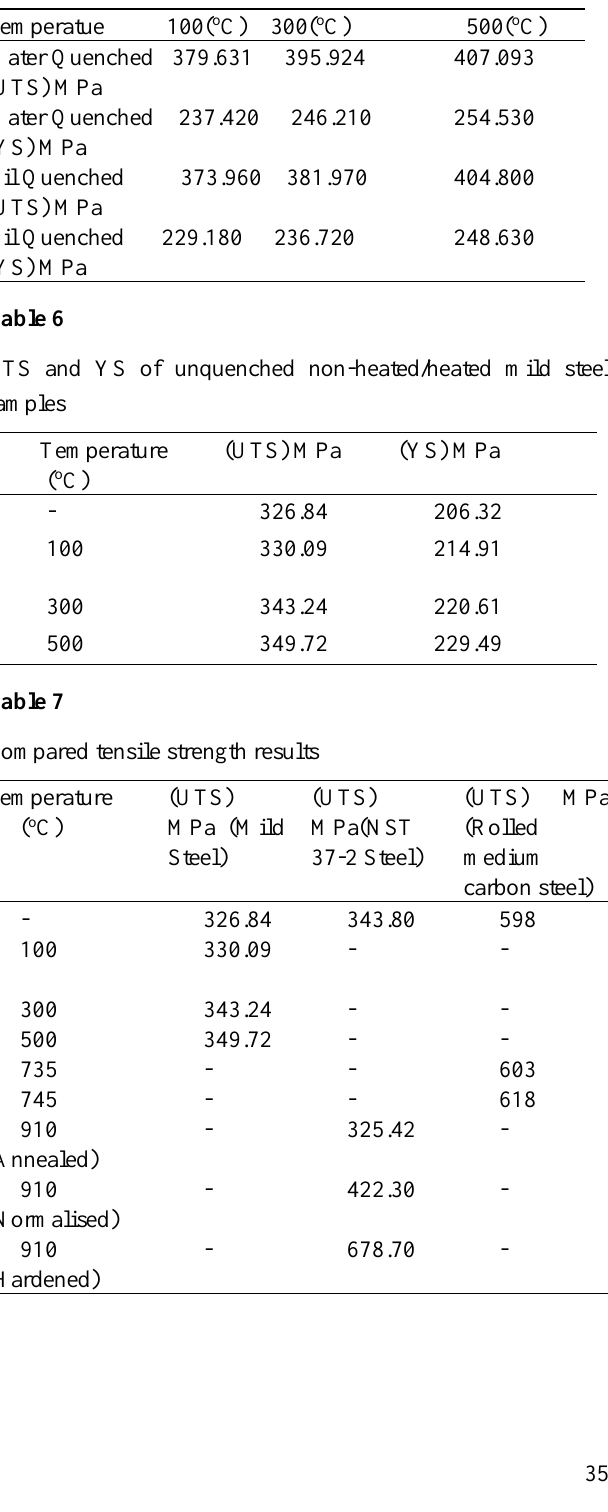
Ultimate tensile strength and yield strength of heat treated mild steel samples